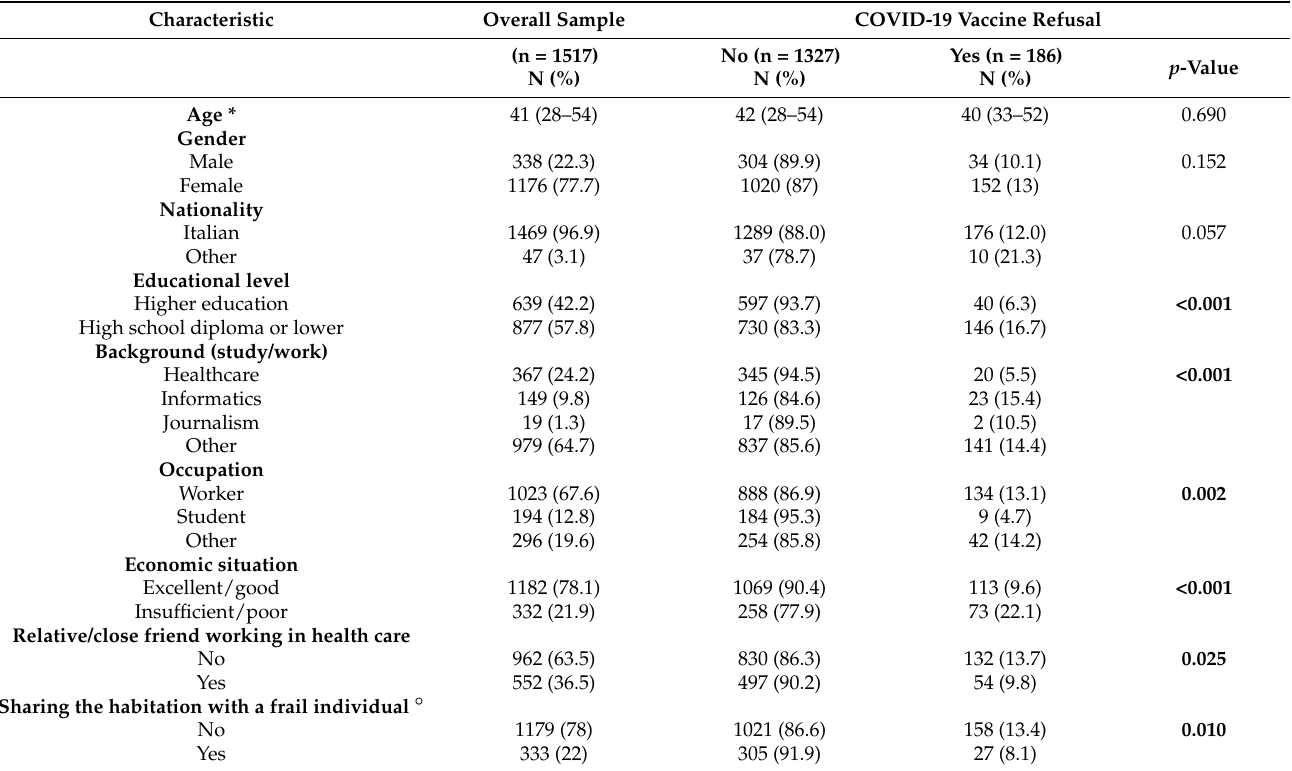
Table 1. Sociodemographic characteristics of the sample and relationship with vaccine